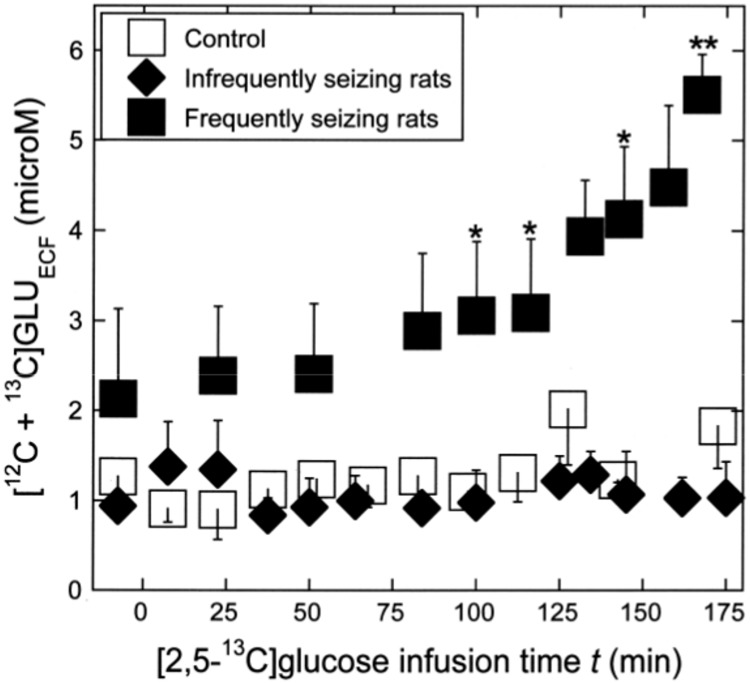
The time course of total [12C + 13C]GLUECF.Total GLUECF showed little changes in the control (open square) or in infrequently seizing rats (black diamond), but in frequently seizing rats (black square) showed gradual elevation between t = 80–120 min and a significant elevation between t = 125–167 min (Fig 4). See text for the explanation of the significant differences at t = 97, 117, 144 and 167 min. Likely explanations for the observed multi-phase increases in the frequently seizing KA rats are described in Discussion.